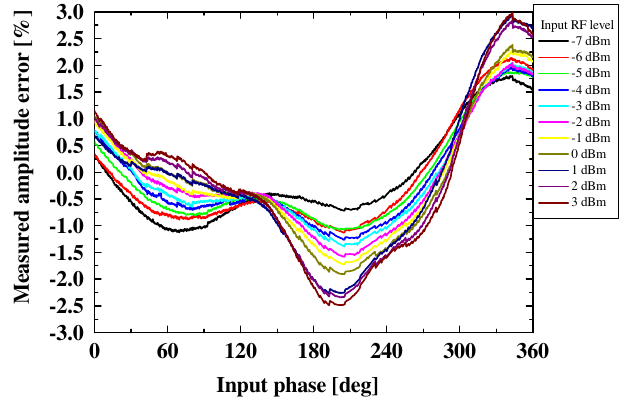
FIG. 7. (Color) Measured amplitude error with the DBM-based I/Q detector.